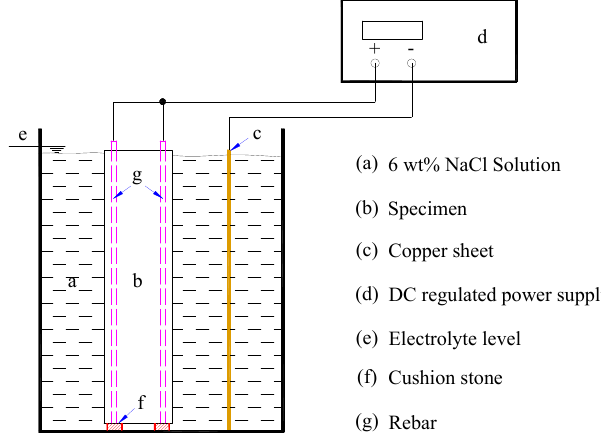
Figure 3. Sketch of the device for accelerating steel